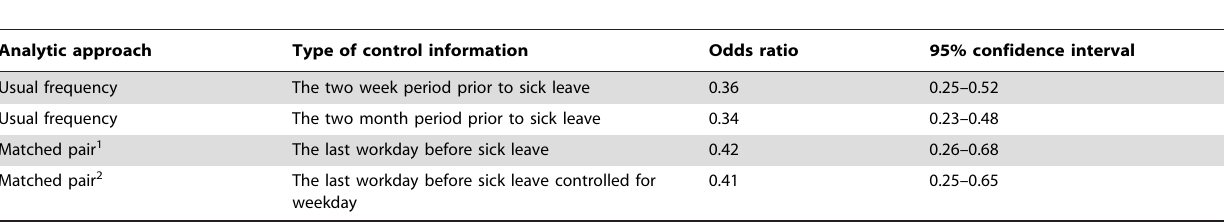
Table 2. Odds ratios of sick leave on a day exposed to lack of adjustment latitude, relative to an unexposed day, with surrounding 95% confidence